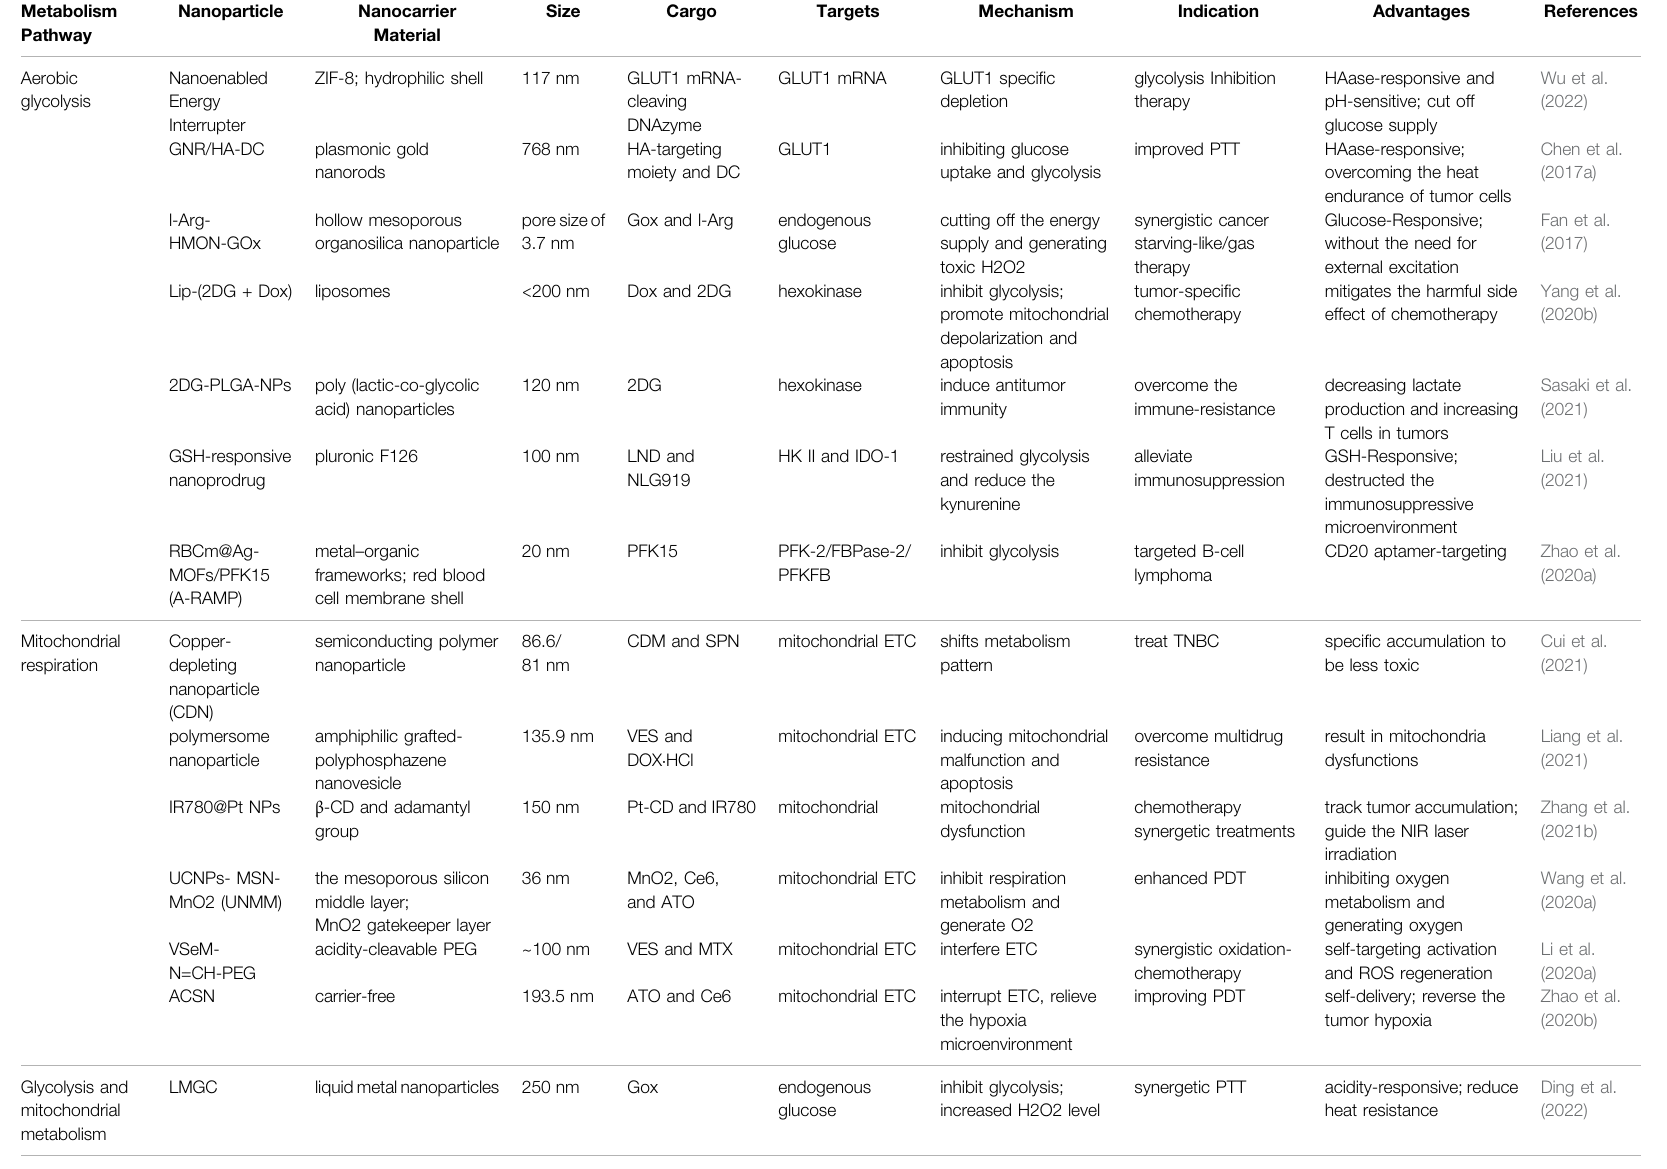
TABLE 1 | Representative nanoparticles targeting cancer